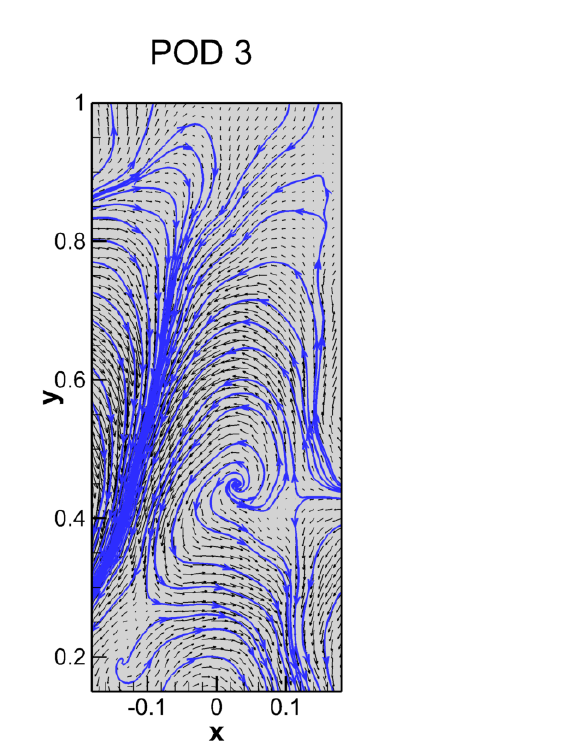
Fig. 12. Velocity POD mode No. 3, 2.4% TKE.